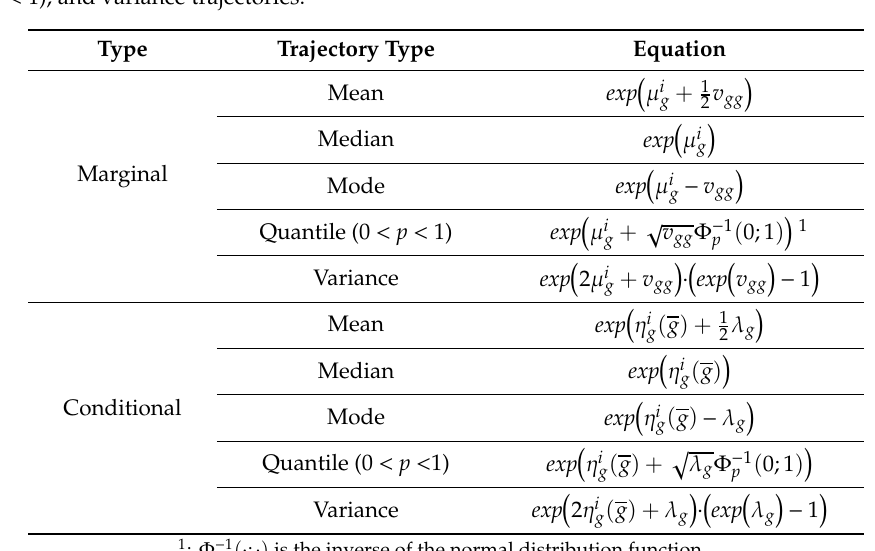
Table 11. Gompertz-type stationary marginal and conditional mean, median, mode, p -quantile (0 < p < 1), and variance trajectories.